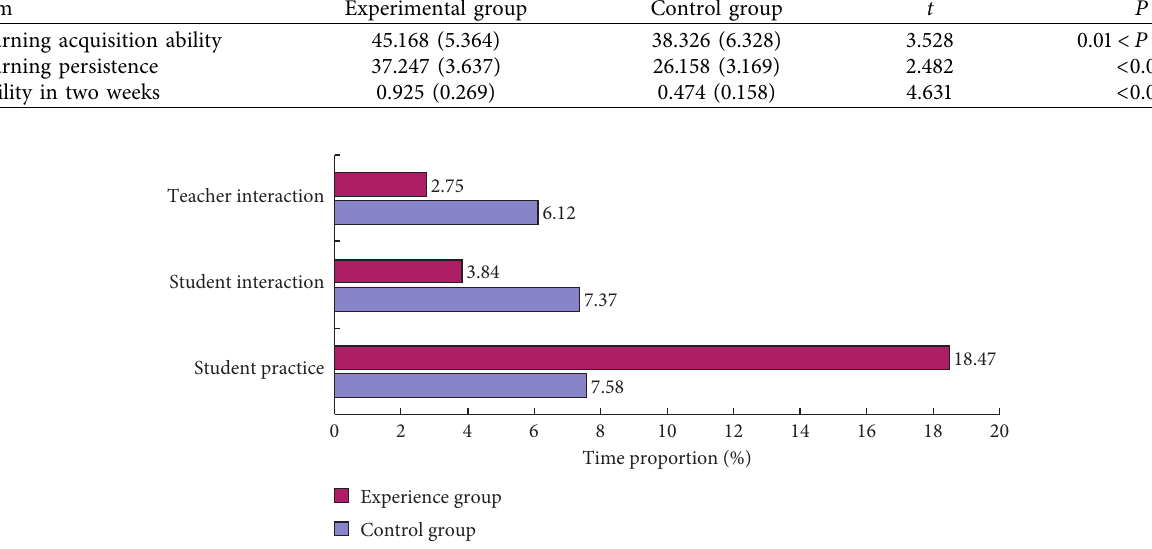
Figure 9: Comparison results of actual operation and interaction time between the two